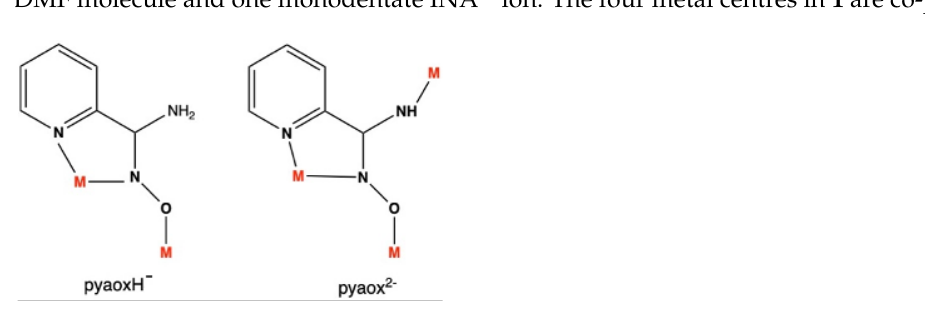
Figure 1. Representation of the molecular structure of 1 . Colour code: Ni, green; N, blue; O, red; C,